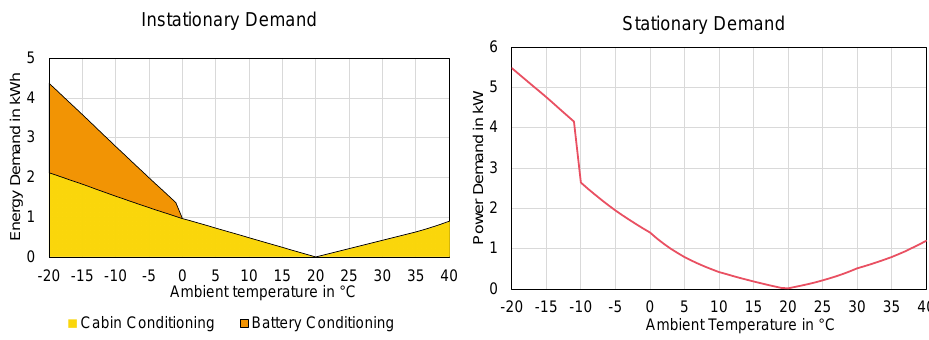
Figure 3. Temperature-related additional stationary power demand and instationary energy